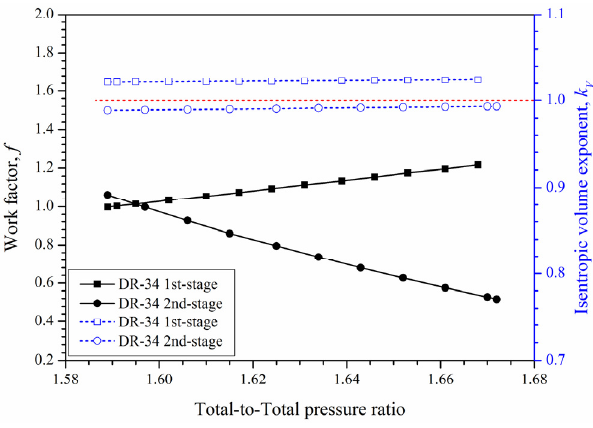
Figure 8. Comparison of work factor and isentropic volume exponent for each stage of DR-34 at 0 % vr .